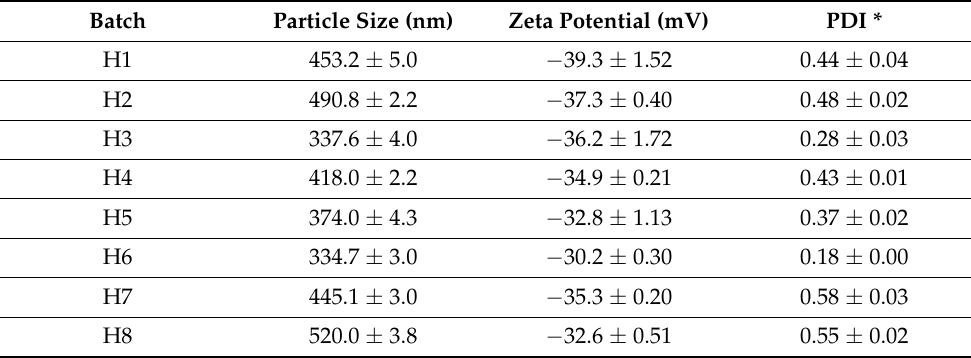
Table 3. Particle size, PDI and zeta potential of nanophytophospholipid batches of